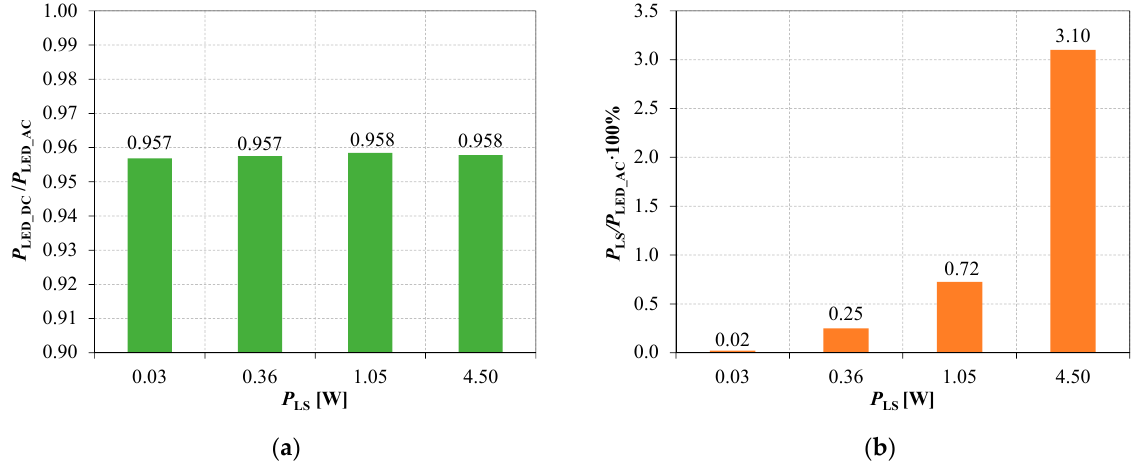
Figure 7. ( a ) LED driver efficiency for various values of the effective power supplying synthetic jet actuator. ( b ) The electrical power delivered to the cooling device as a percentage of the electric power delivered to the LED lamp.